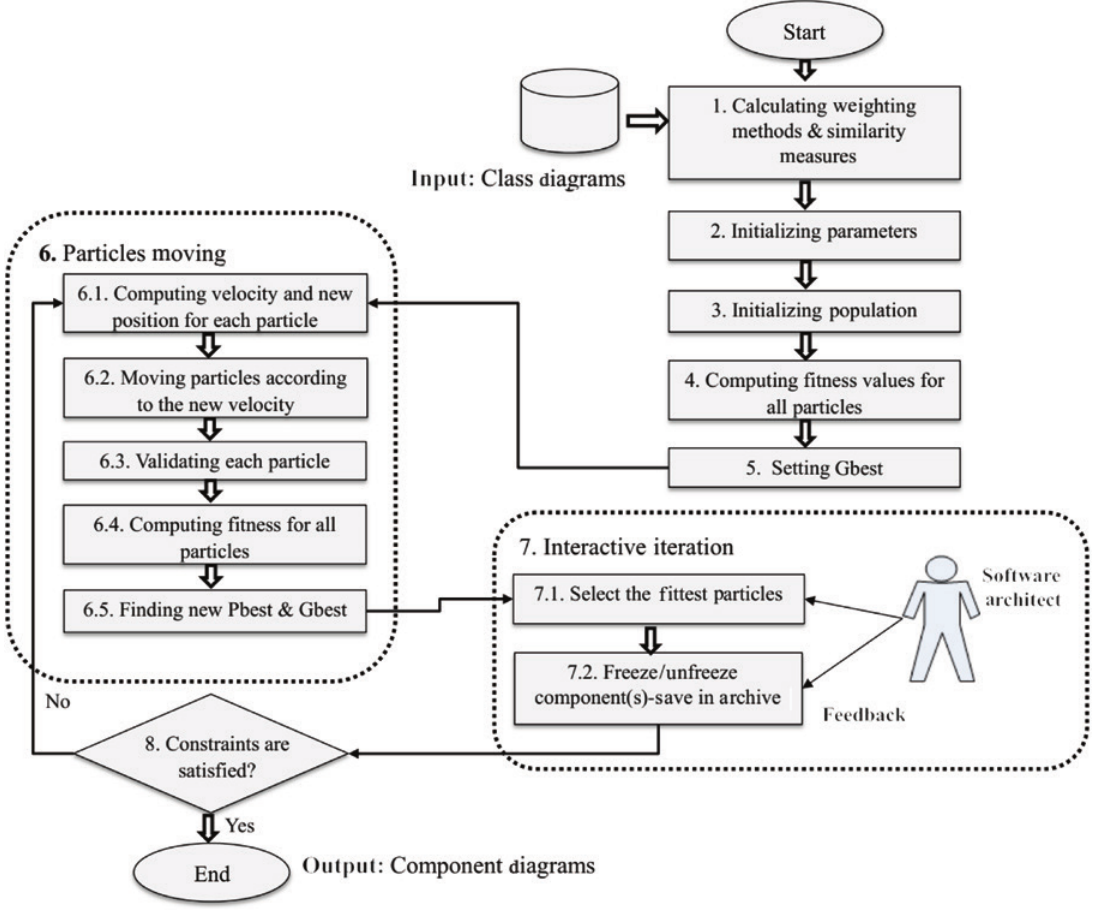
Figure 1: Process of the Proposed PCI-PSO